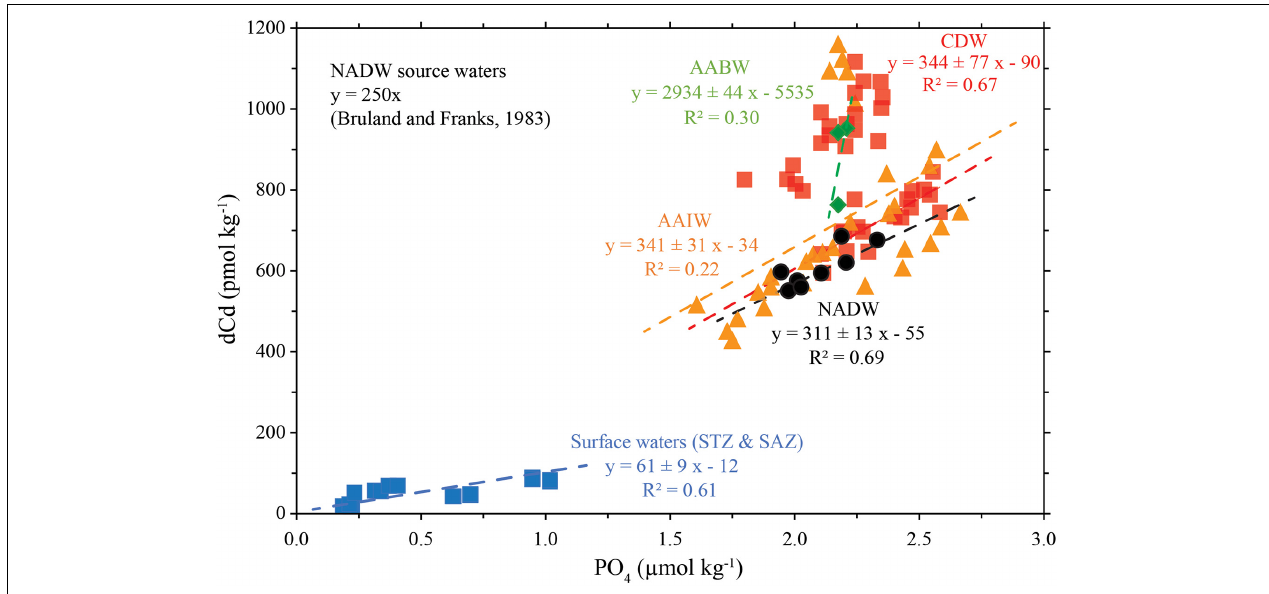
FIGURE 8 | Plot of dCd/dPO 4 ratios, defined as the slope of regression between dCd and PO 4 , for various water